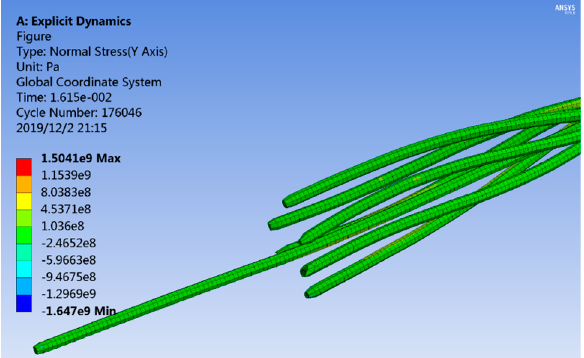
Figure 15. Fracture of the seven-wire strands simulated by a finite element simulation. Table 1. The ultimate tensile strengths of the seven-wire strands at different lateral bending angles by finite element analysis.